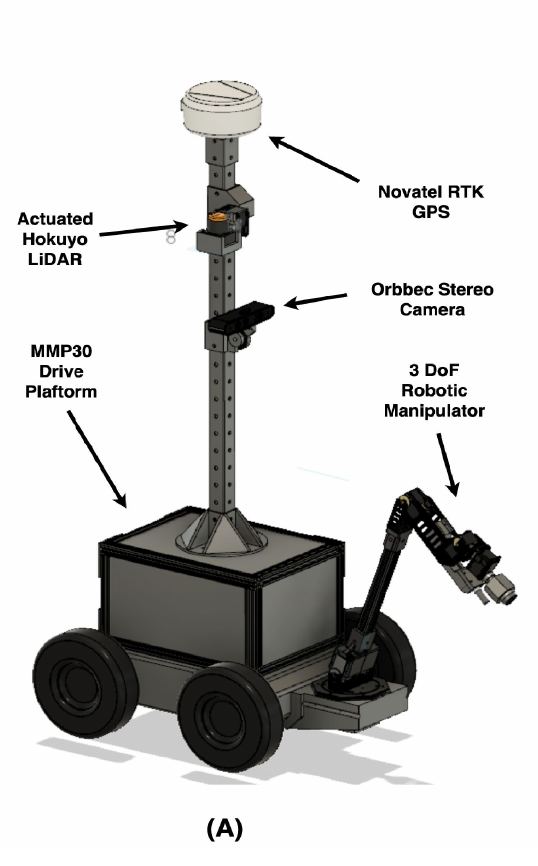
Figure 1. MARIA: An autonomous differential drive rover. ( A ) CAD model of Multipurpose Autonomous Robot of Intelligent Agriculture (MARIA); ( B ) Picture of MARIA.